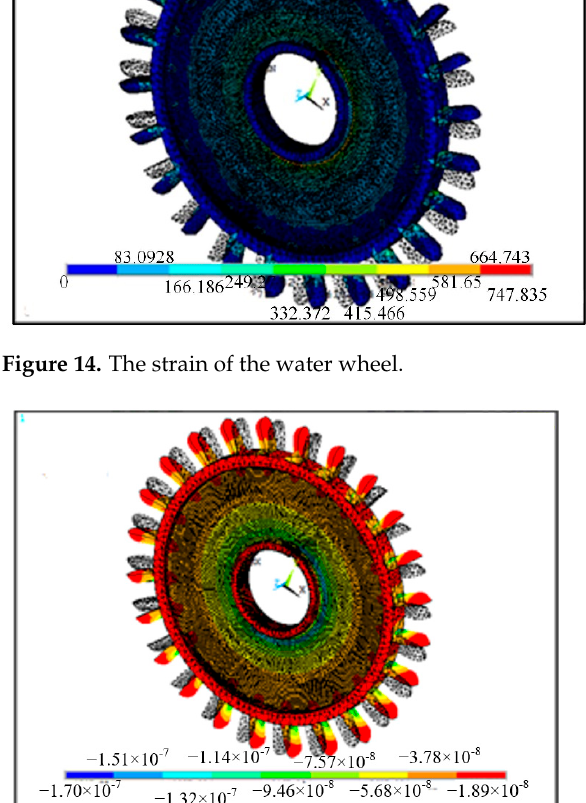
Figure 15. The stress of the water wheel (unit: MPa).